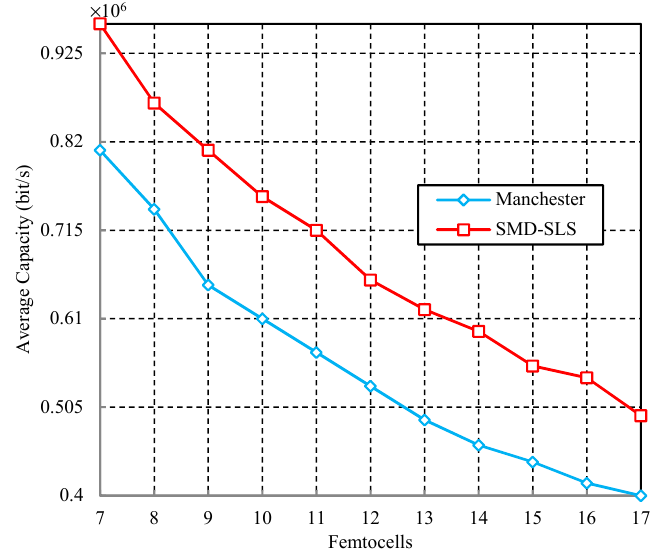
Figure 9. Dropping ratio of proposed vs Manchester methods in homogeneous network.